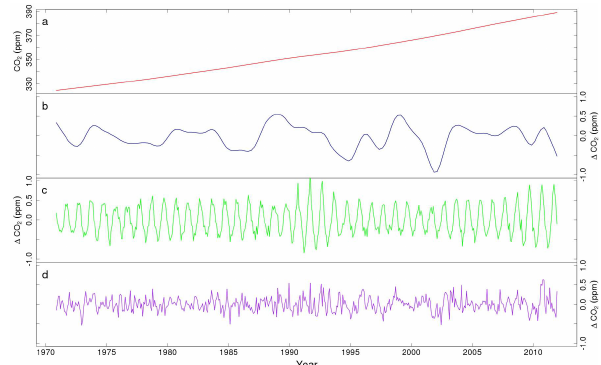
Fig. 3. Baring Head CO 2 time series, showing all hourly averages (black) and data filtered for steady southerly periods as described in the text (red). The filtered data are shown as average values for the entire steady period. The years from 1987–1994 with truncated hourly CO 2 peaks resulted from an intentional adjustment of the an- alyzer output range to increase sensitivity during southerly wind pe- riods, but sacrificing measurements during locally influenced high CO 2 episodes. With the focus on the steady period data, the hourly average record was not historically scrutinized. Low CO 2 anomalies in the hourly average record prior to 2002 likely result from instru- mentation problems, and work is currently underway to use hand- written notes to identify and filter such events out. Prior to 1978, high-rate measurements were recorded on strip charts, but only the steady period data are available in digital form. The plotted data prior to December 1972 are from the Makara site.